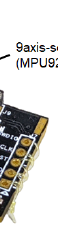
( a ) Accelerometer raw data.